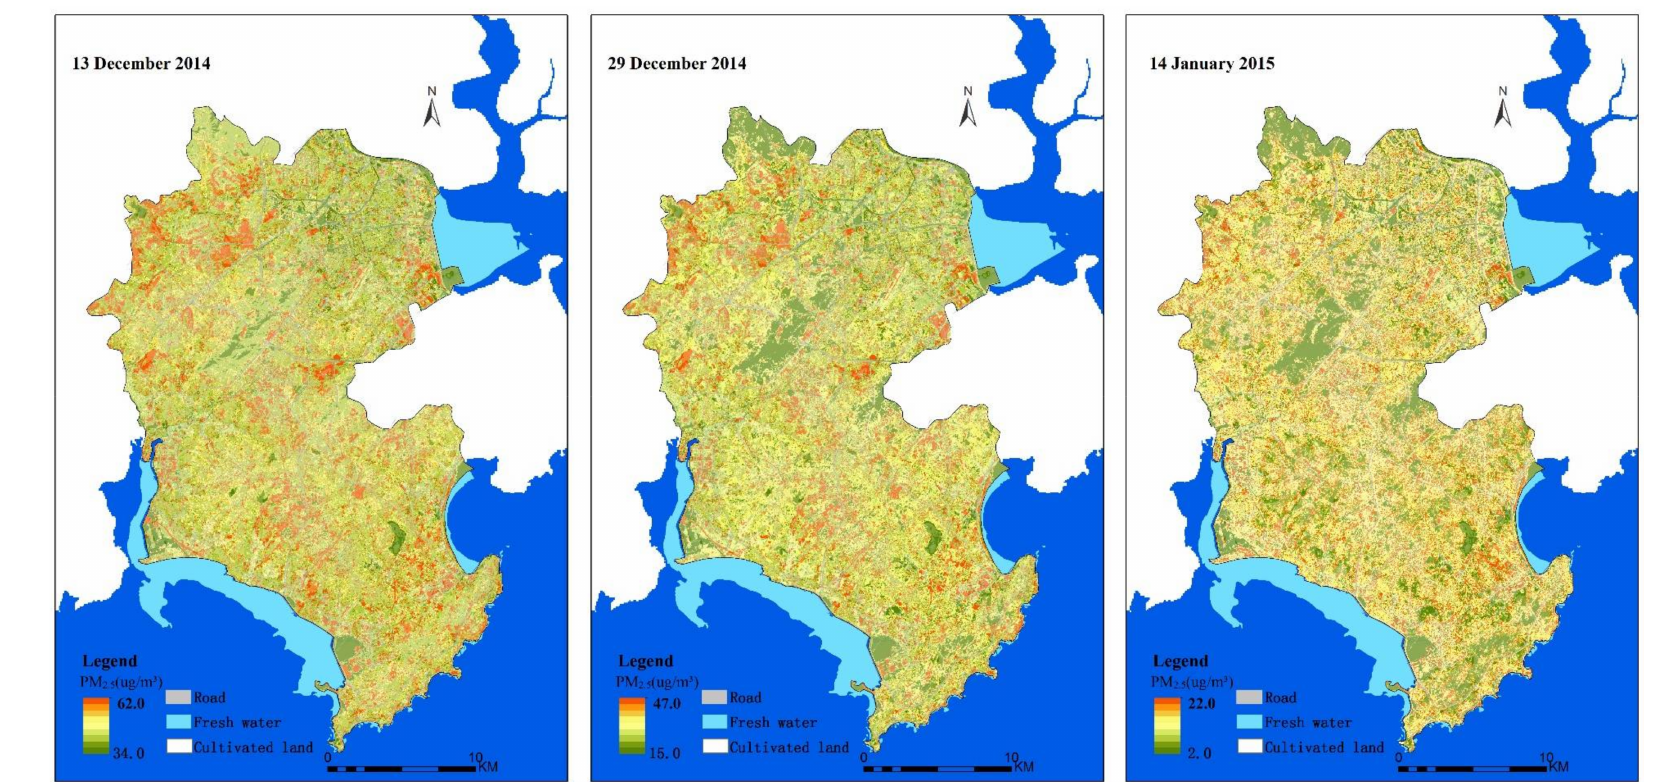
Figure 2. Spatial distributions of urban forest PM 2.5 concentrations on three different days at the optimal distance threshold of 3500